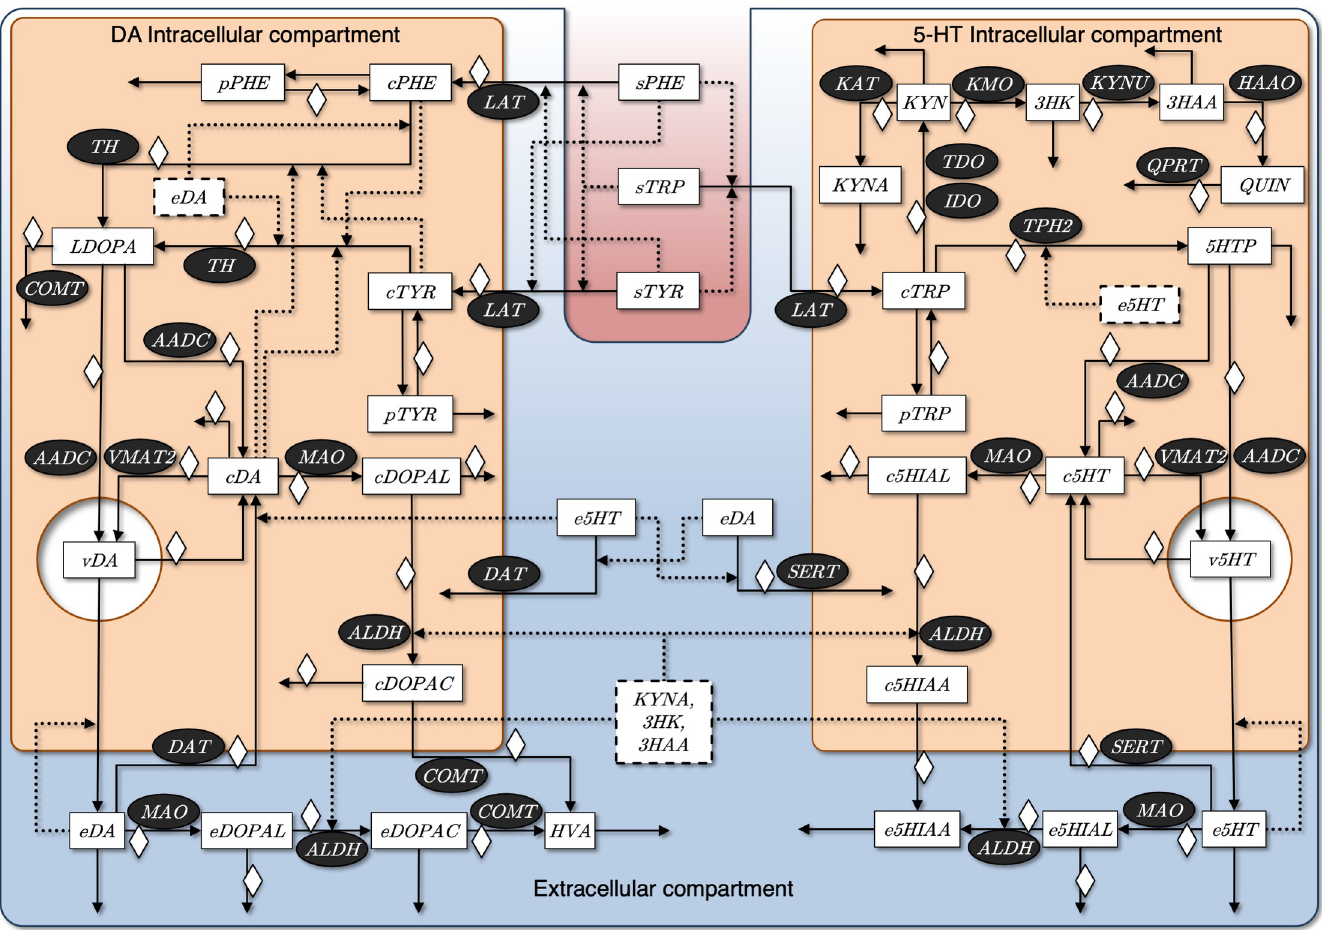
Fig 1. Conceptual, simplified model of pathways associated with MDD and their interactions in the presynaptic DA and 5-HT terminals. The model accounts for separate cytosolic and vesicular compartments in the two terminals, which share the same extracellular space. The latter is an important “collective” location for processes that take place outside the neurons, in particular, in the synaptic cleft or in glial cells. Metabolites are represented with white boxes and participating enzymes with black ellipses. Metabolites in dashed boxes are important but not necessarily located in the compartment where they are represented. Prefixes s , c , v , e , and p refer to metabolites in the serum, cytosol, vesicles, extracellular space and pool of proteins, respectively. Cortisol/corticosterone (CORT) is represented by a white diamond. Serum tyrosine, phenylalanine, tryptophan, enzymes and CORT are independent variables that remain constant during a given experiment. The strongest inhibitory effects are represented with dotted lines. Abbreviations: 3-HAA, 3-hydroxyanthranilic acid; 3-HK, 3-hydroxykynurenine; 5-HIAA, 5-hydroxyindoleacetic acid; 5-HIAL, 5-hydroxyindoleacetaldehyde; 5-HT, 5-hydroxytryptamine or serotonin; 5-HTP, 5-hydroxytryptophan; AADC, l-amino acid decarboxylase; ALDH, aldehyde dehydrogenase; COMT, catechol O-methyltransferase; DA, dopamine; DAT, dopamine transporter; DOPAC, 3,4-dihydroxyphenylacetic acid; DOPAL, 3,4-dihydroxyphenylacetaldehyde; HAAO, 3-hydroxyanthranilate 3,4-dioxygenase; HVA, homovanillic acid; IDO, indoleamine 2,3-dioxygenase; KAT, kynurenine aminotransferase; KMO, kynurenine 3-monooxygenase; KP, kynurenine pathway; KYN, kynurenine; KYNA, kynurenic acid; KYNU, kynureninase; LAT, L-type amino acid transporter; L-DOPA, l-3,4-hydroxyphenylalanine; MAO, monoamine oxidase; PHE, phenylalanine; QPRT, quinolinate phosphoribosyltransferase; QUIN, quinolinic acid; SERT, serotonin transporter; TDO, tryptophan-2,3-dioxygenase; TH, tyrosine hydroxylase; TPH2, tryptophan hydroxylase 2; TRP, tryptophan; TYR, tyrosine; VMAT2, vesicular monoamine transporter 2.